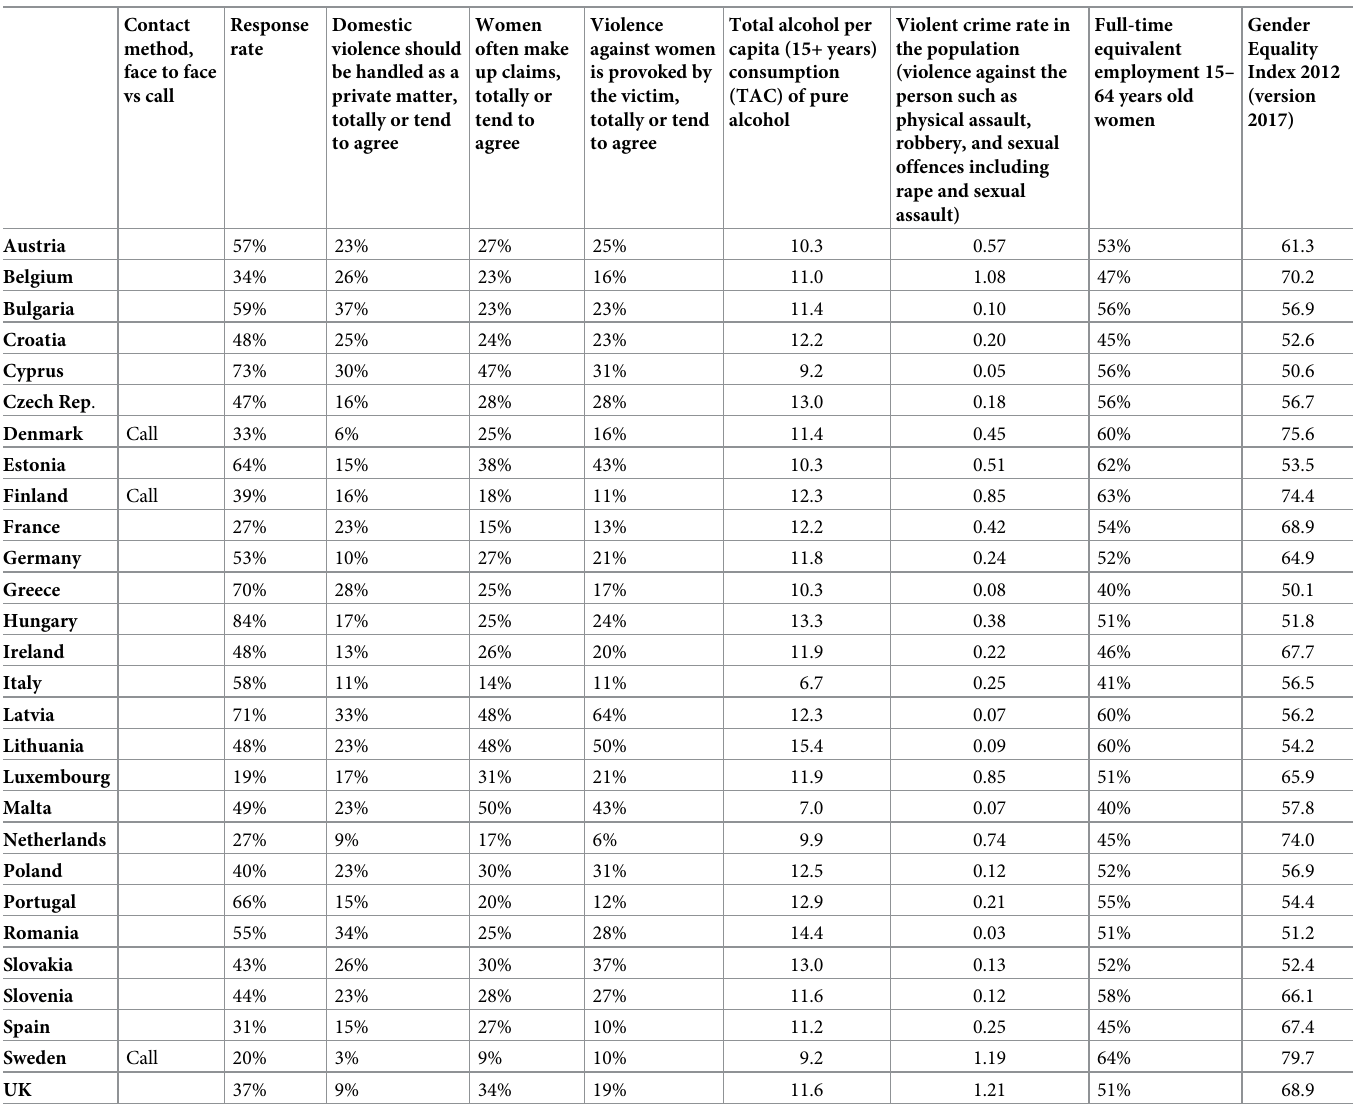
Table 6. Country level